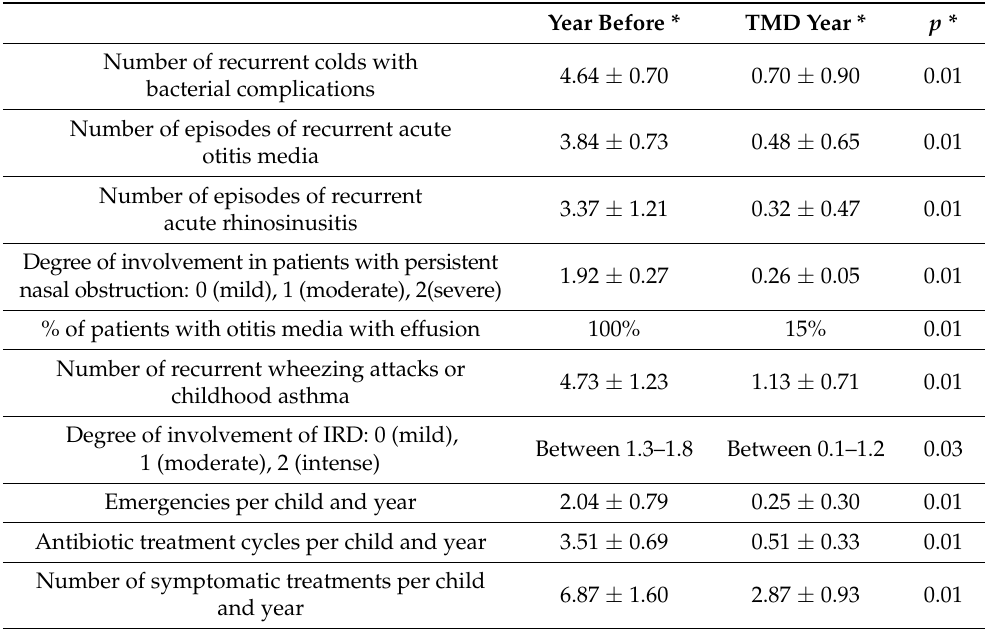
Table 4. Mean acute episodes of IRD during the year prior to diagnosis and after the application of the